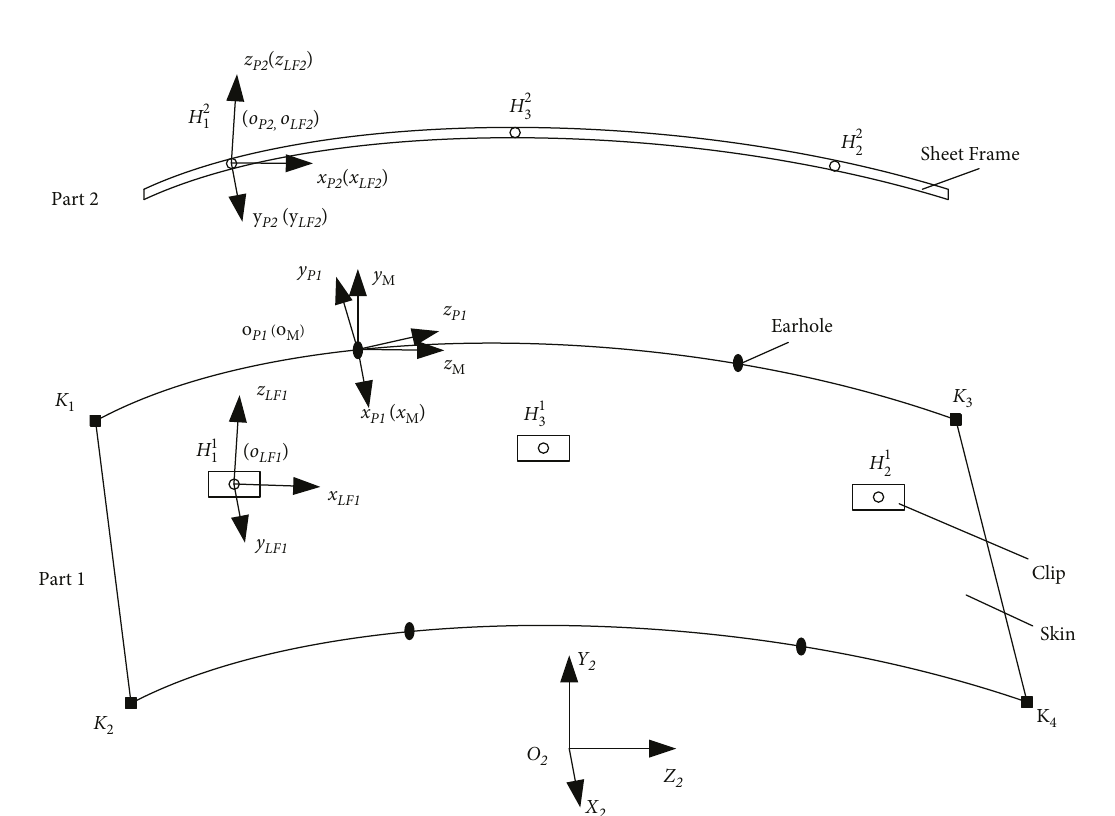
Figure 2: A subassembly and a sheet